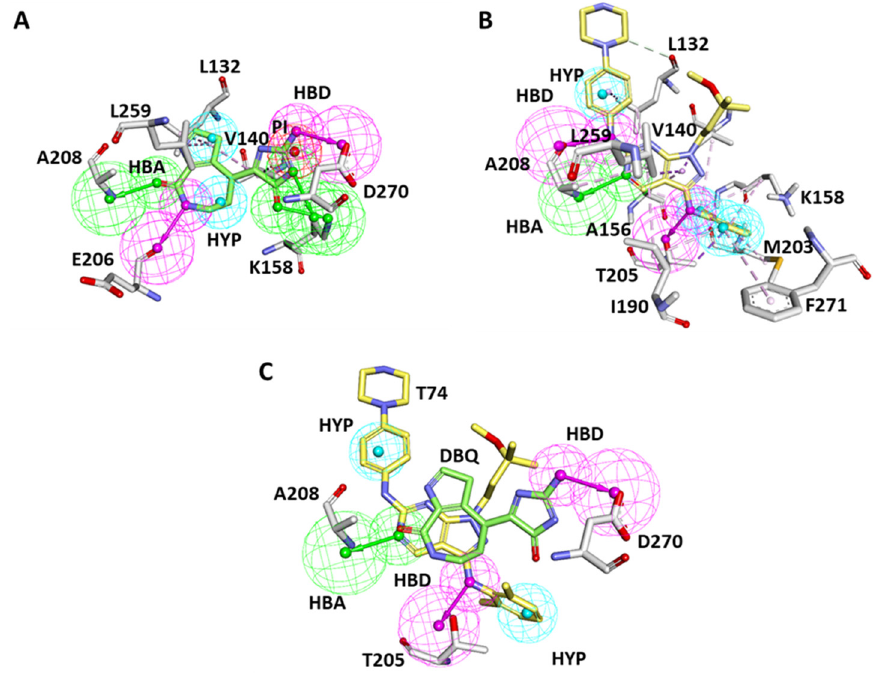
Figure 3. Pharmacophore mapping with active site residues of ACK1 ( A ) PDB id: 1U4D and ( B ) 3EQR overlaid on Pharm A and Pharma B, respectively. The co-crystalized ligands DBQ and T74 are shown with green and yellow sticks. The active site residues are shown with gray sticks. ( C ) Final hybrid pharmacophore model. The key residues A208, T205, and D270 mapped with hydrogen bond acceptor and donor features are shown.